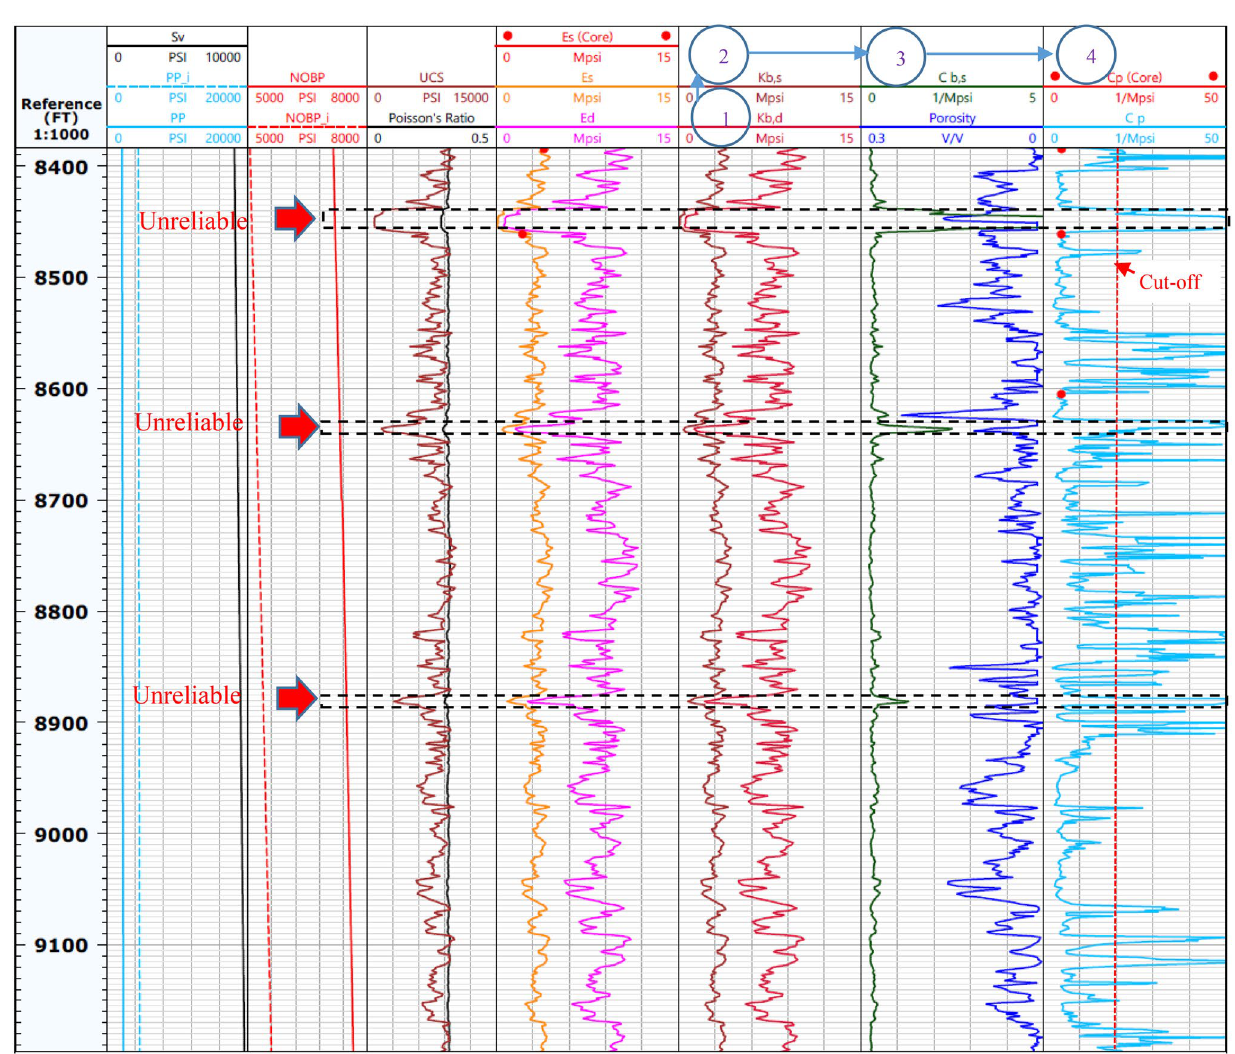
Fig. 3 Geomechanical Earth Model (MEM) constructed for the well under study, including rock moduli, strength and compressibility coefficients for the formation (8383–9187 ft (2555–2800 m). Four of the pore compressibility evaluation steps are indicated in the figure. Legend: Sv, Vertical Stress; PP_i, initial formation pore pressure; PP, current pore pressure; NOBP, net over-burden pressure; NOBP_i, ini-